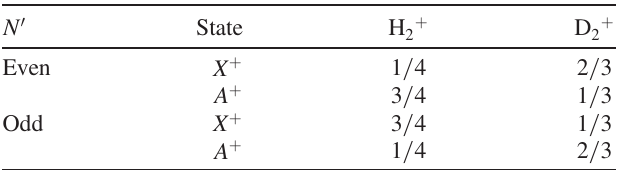
TABLE III. Probabilities p wave N 0 in the vibrational continuum of state i ¼ f X þ ; A þ g for H 2 þ and D 2 þ